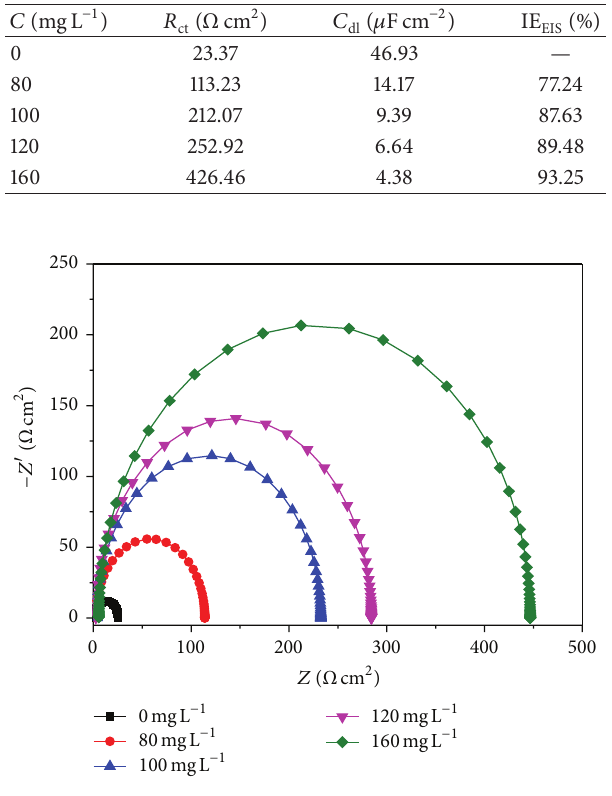
Figure 7: Nyquist plots for carbon steel in 0.5 M HCl in the absence and presence of different concentrations of EAPP at 300 K.